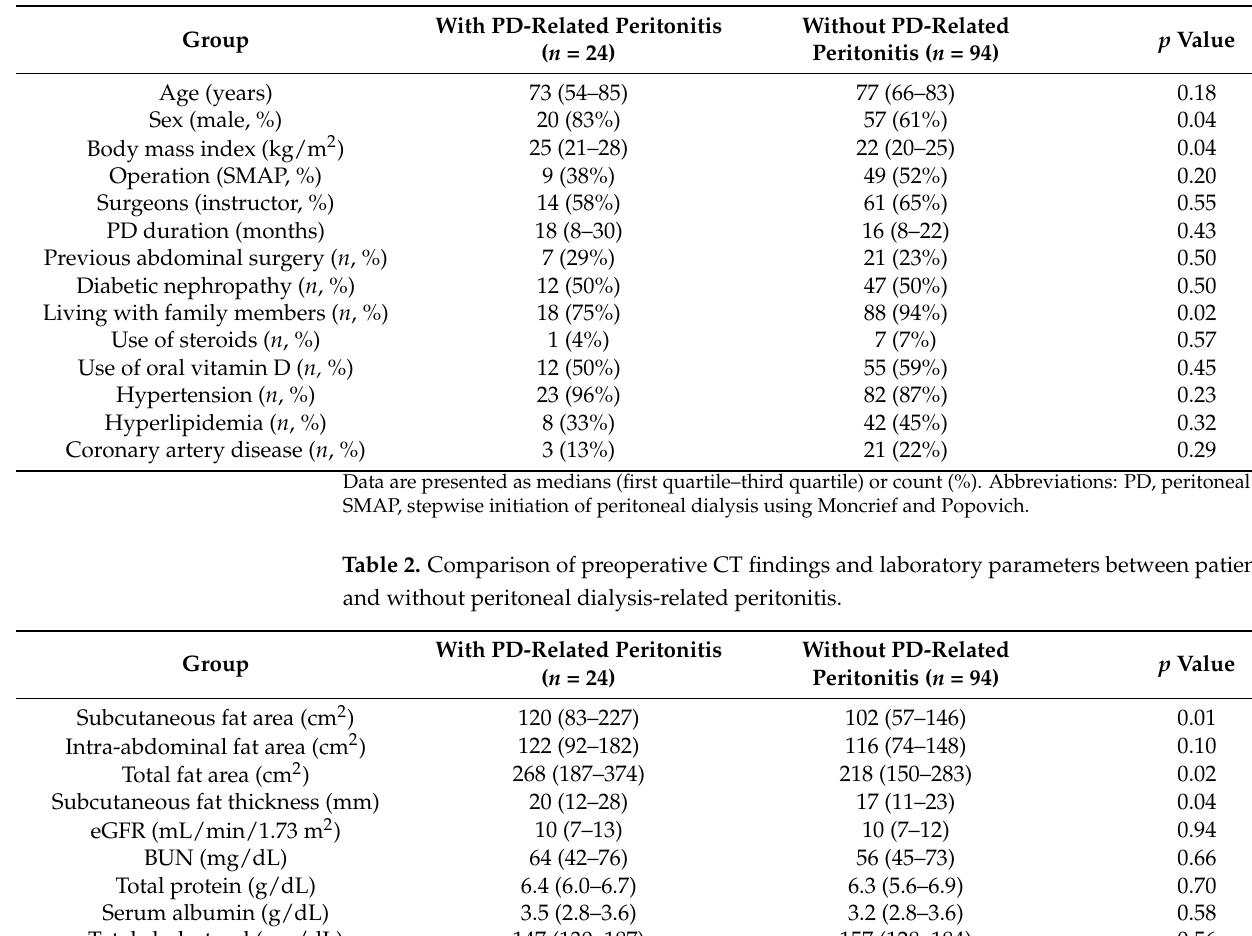
Table 1. Comparison of background characteristics between patients with and without peritoneal dialysis-related peritonitis.